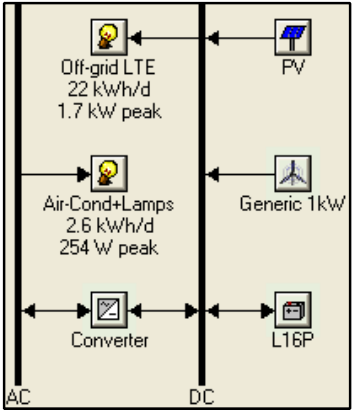
Figure 4. Micro-power system modelling in HOMER.